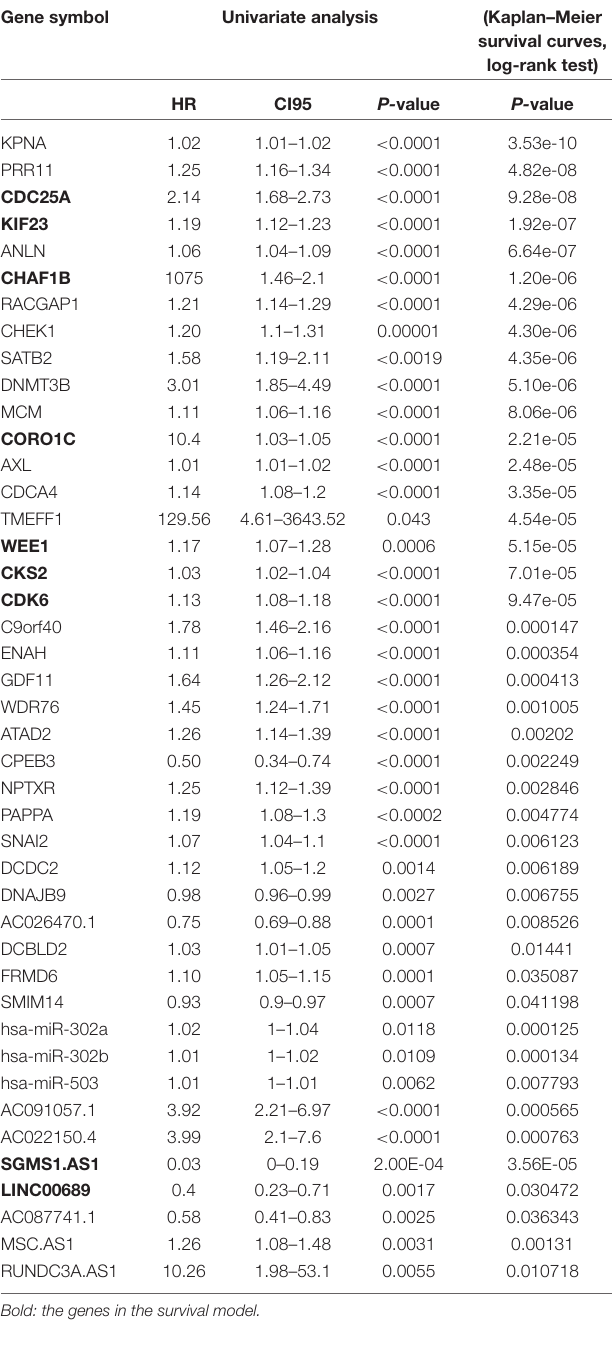
c5.all.v6.2.entrez.gmt gene set ( Figure 2E ), supporting the role of the extracellular matrix in the progression of MPM and indicating the convergence between the invasion of MPM and the morphogenesis and differentiation of the